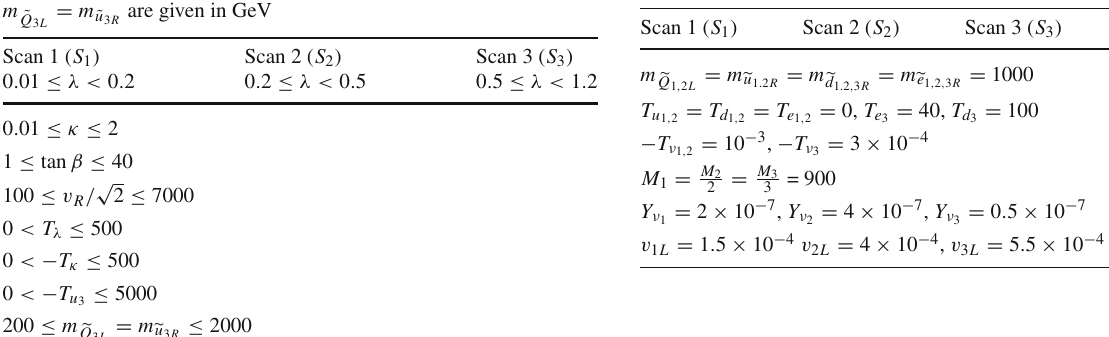
Table 2 Low-energy values of the input parameters that are fixed in the three scans. The VEVs v iL and the soft parameters T u , d , e , m (cid:6) Q , (cid:6) u , (cid:6) d , (cid:6) e , M 1 , 2 , 3 are given in , 3